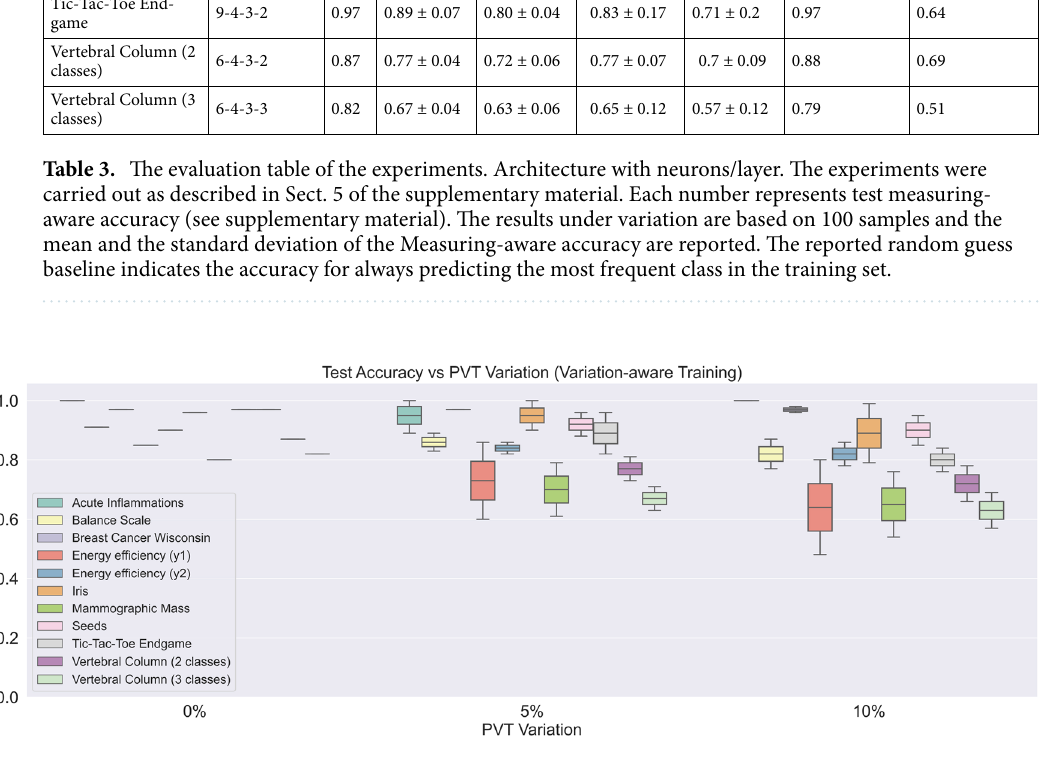
Figure 7. PVT analysis—inference accuracy of pNN using variation-aware training procedure. Variation parameter represents the coefficient of variation of the process, voltage and temperature variation models. The middle lines in the boxes refer to the mean test accuracy, while the whiskers depict the standard deviation.